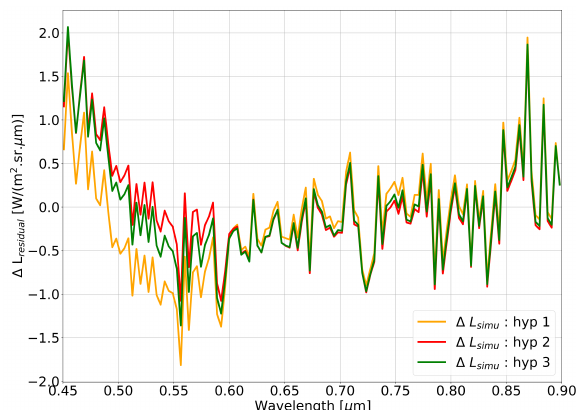
Figure 2. Signature of plume scattering residual aerosols according to several plume modellings compared to the plume measured signature over water. The hypotheses 1, 2 and 3 correspond respectively to an infinite plume (yellow), a semi-punctual plume (red) and a punctual plume(green).